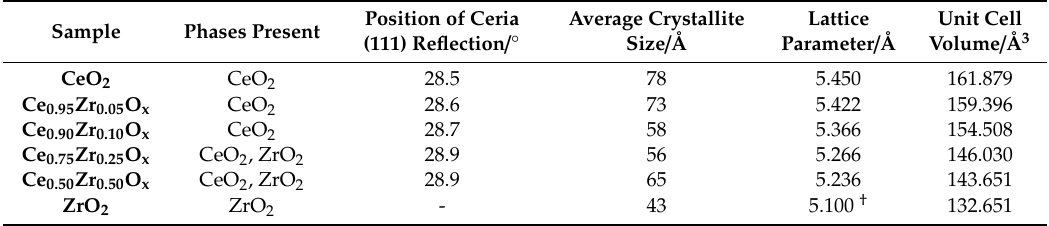
Table 1. Crystallographic properties of the ceria–zirconia mixed metal oxide catalysts calculated from powder XRD